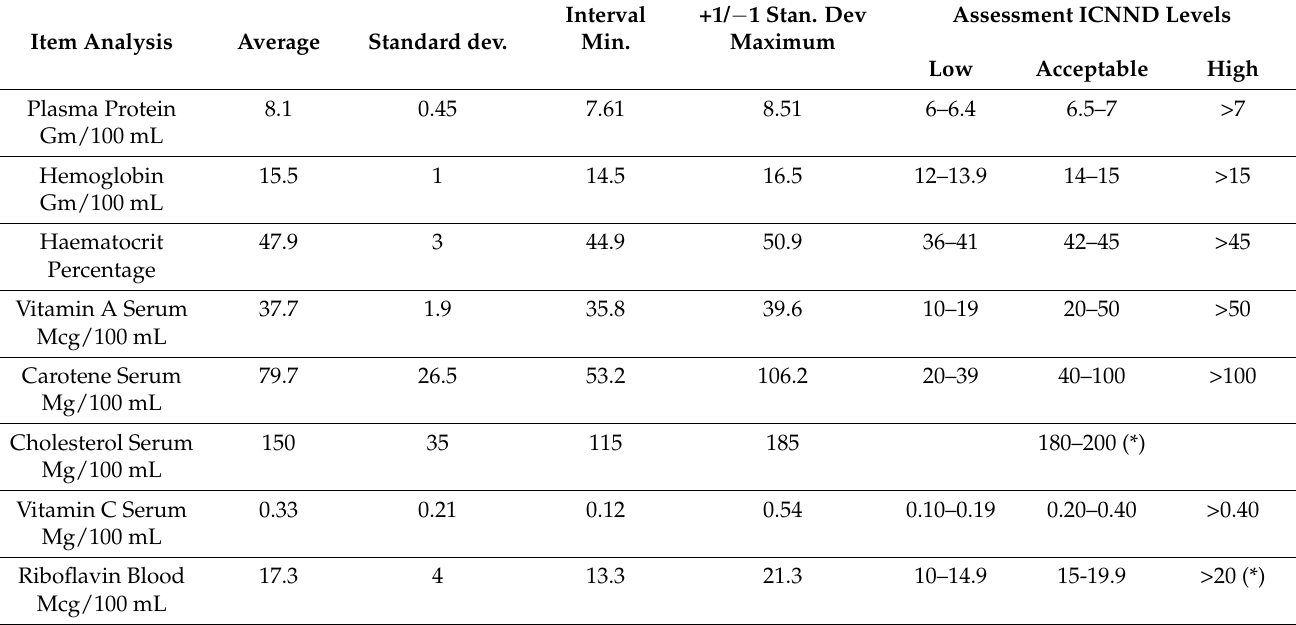
Table 9. Biochemical indicators in blood and urine